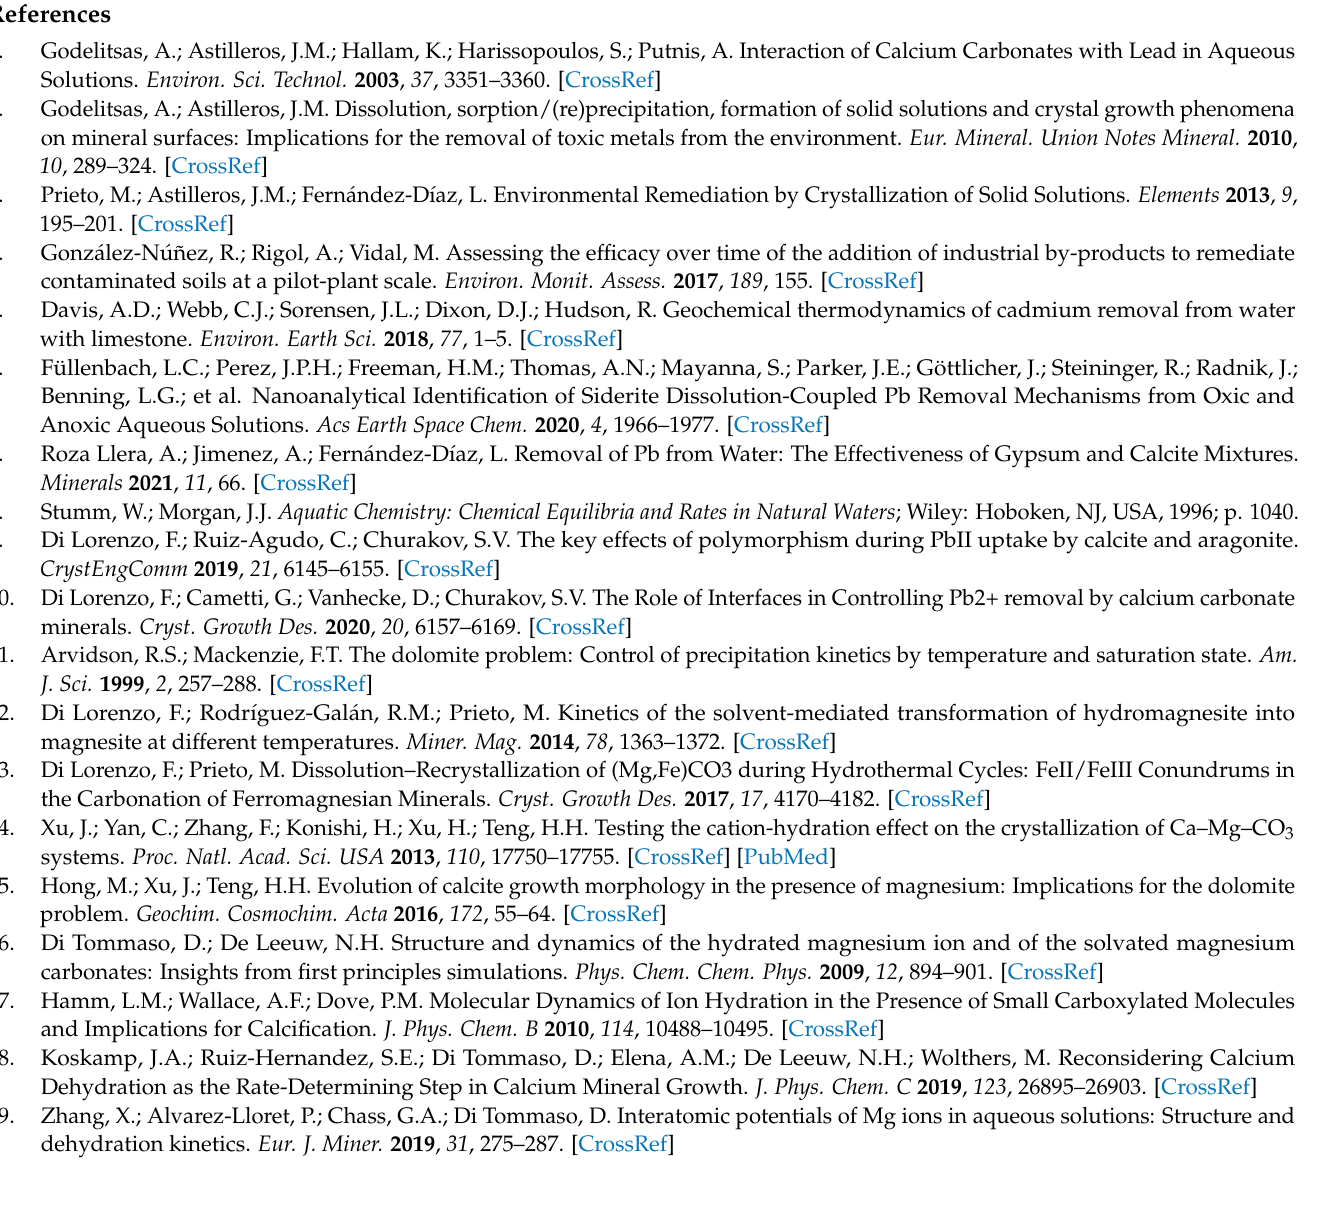
temperature. Figure S4: Variation of magnesite dissolution rate as a function of